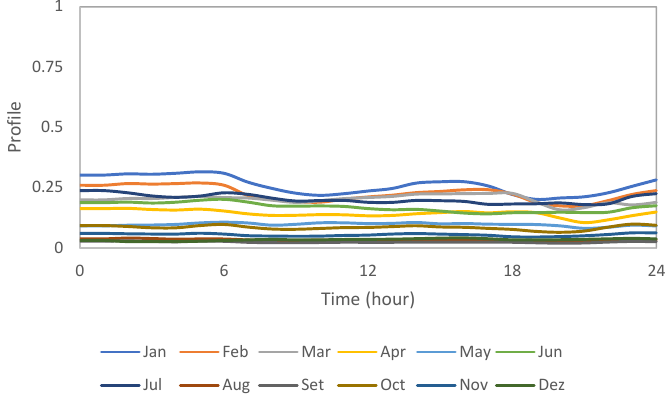
Figure A6. Average daily profile of electricity generation from coal, per